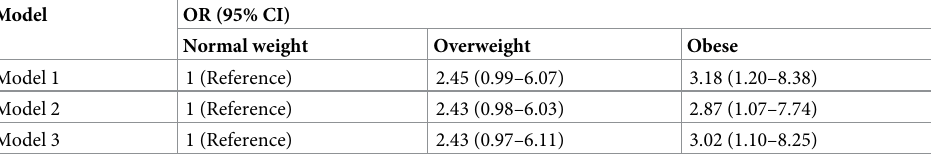
Table 3. Multivariate analysis of the association between BMI category and